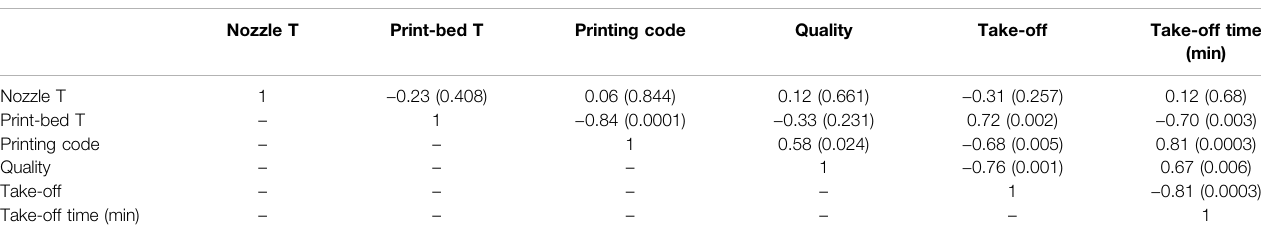
TABLE 4 | Pearson ’ s correlation among thermal parameters and fi nal printing results a .